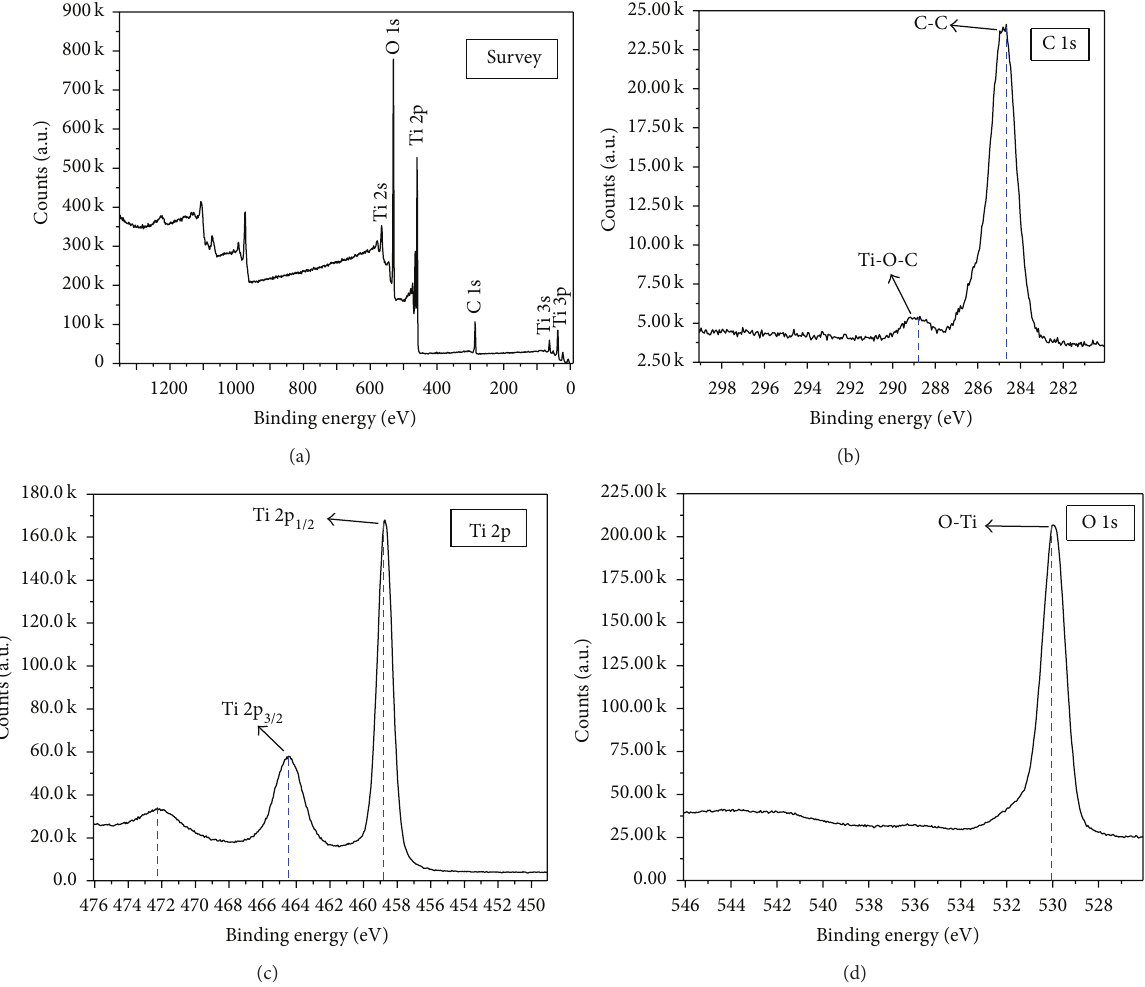
Figure 5: (a) XPS full spectrum of TiO 2 sample. (b) High resolution XPS of C 1s and subpeak fitting chart. (c) High resolution XPS of Ti 2p and subpeak fitting chart. (d) High resolution XPS of O 1s and subpeak fitting